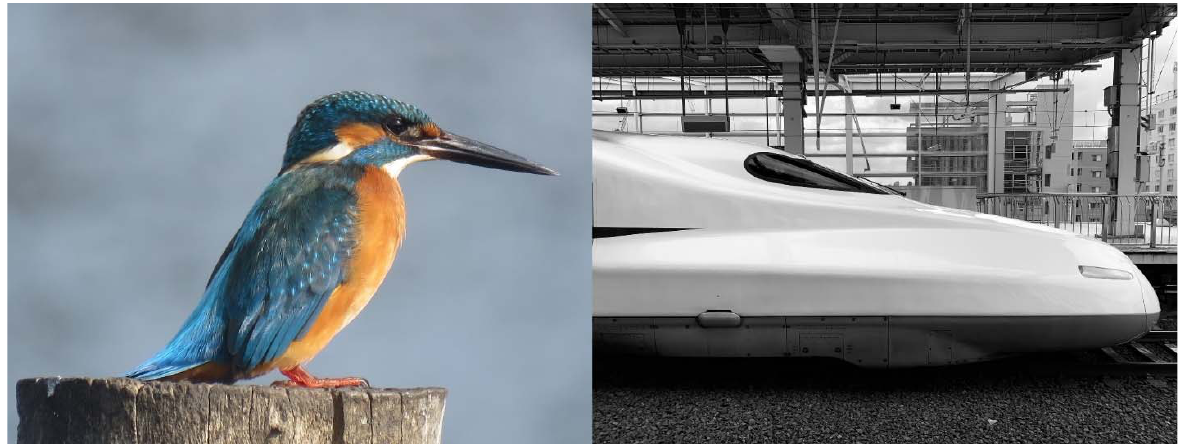
Figure 2. Kingfisher and a bullet train in Japan.